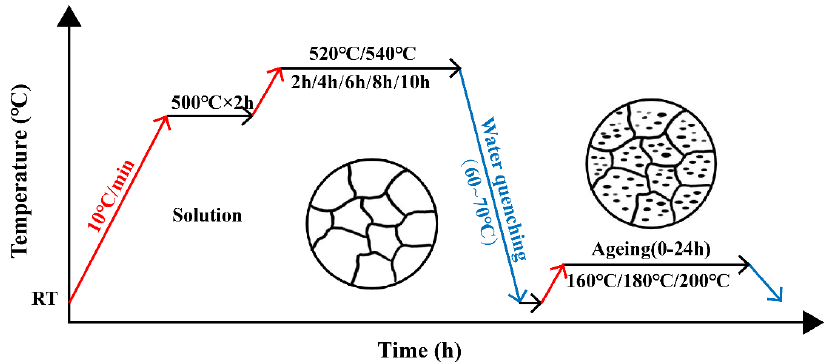
Figure 2. Schematic diagram of the heat treatment